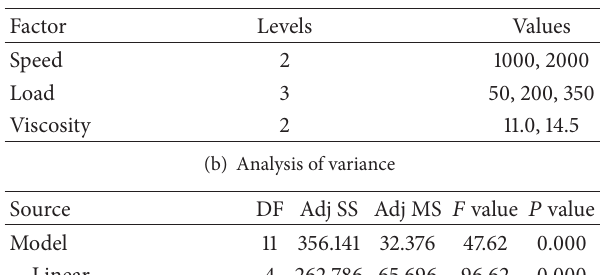
Table 5: General factorial regression: FP versus speed, load, and viscosity.